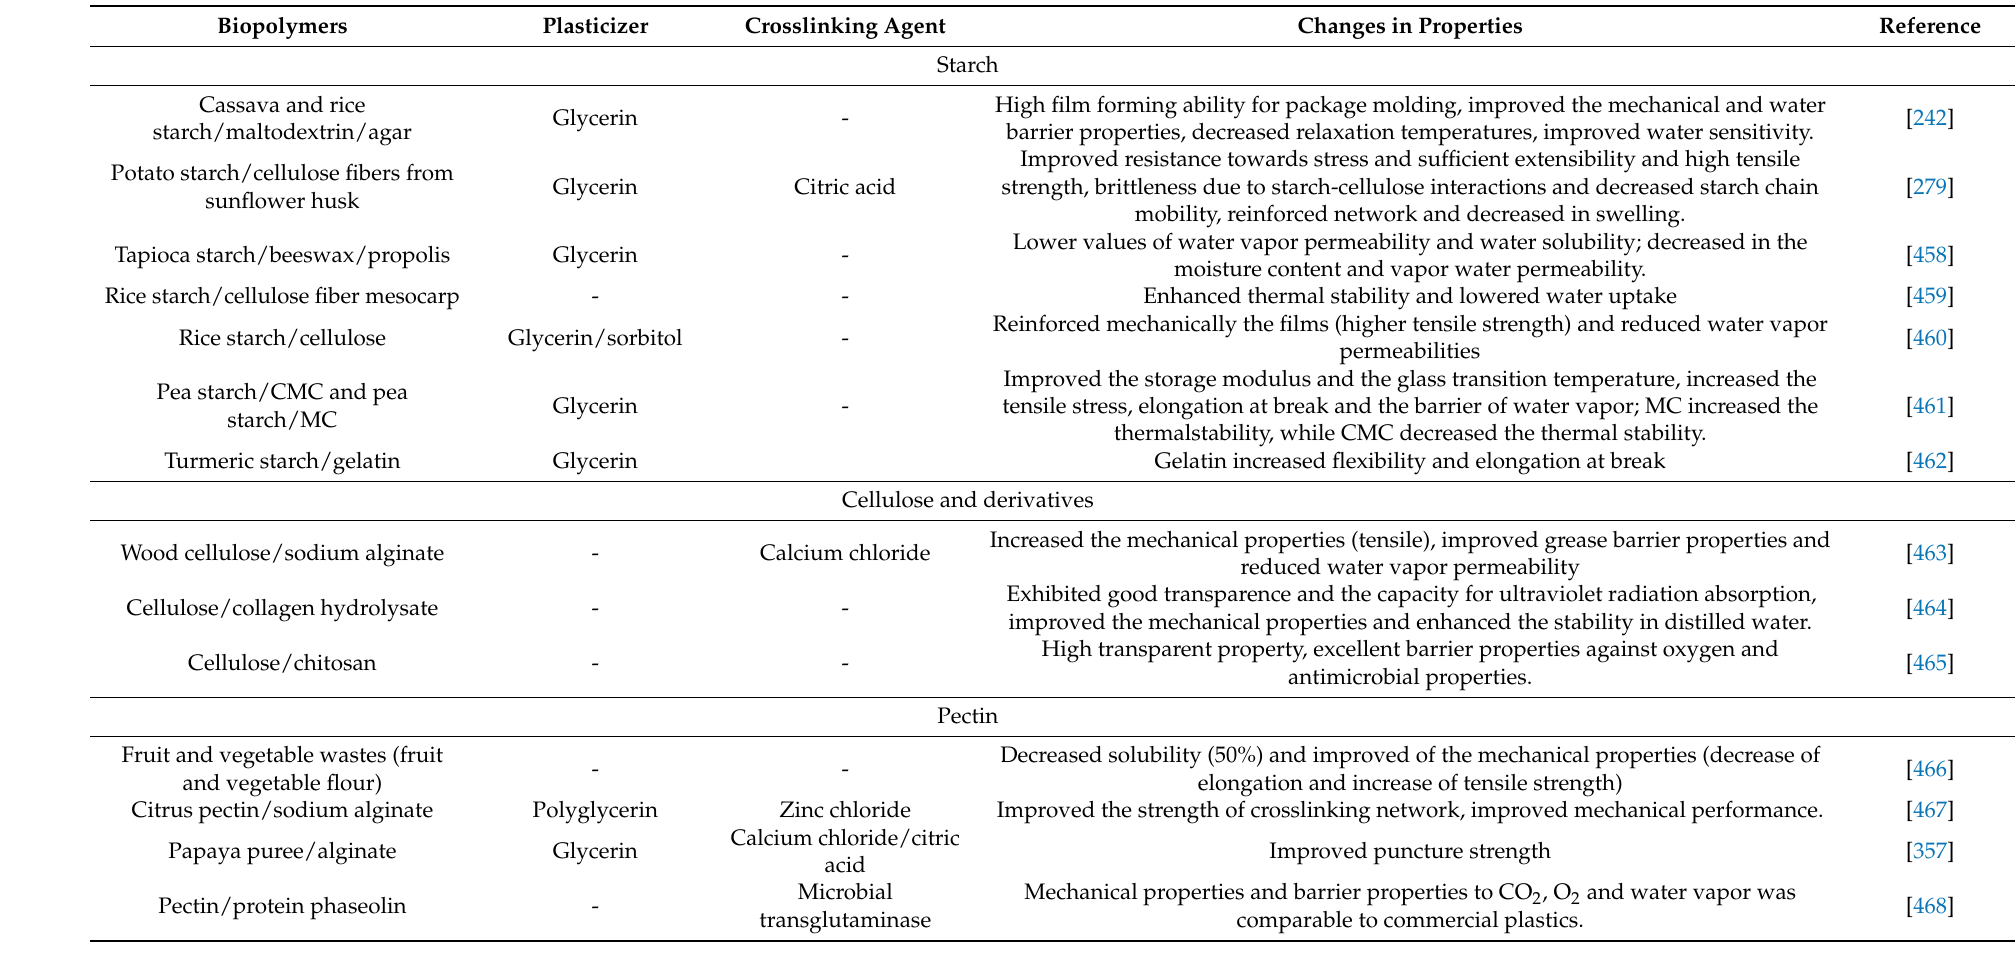
Table 2. Examples of composites edible